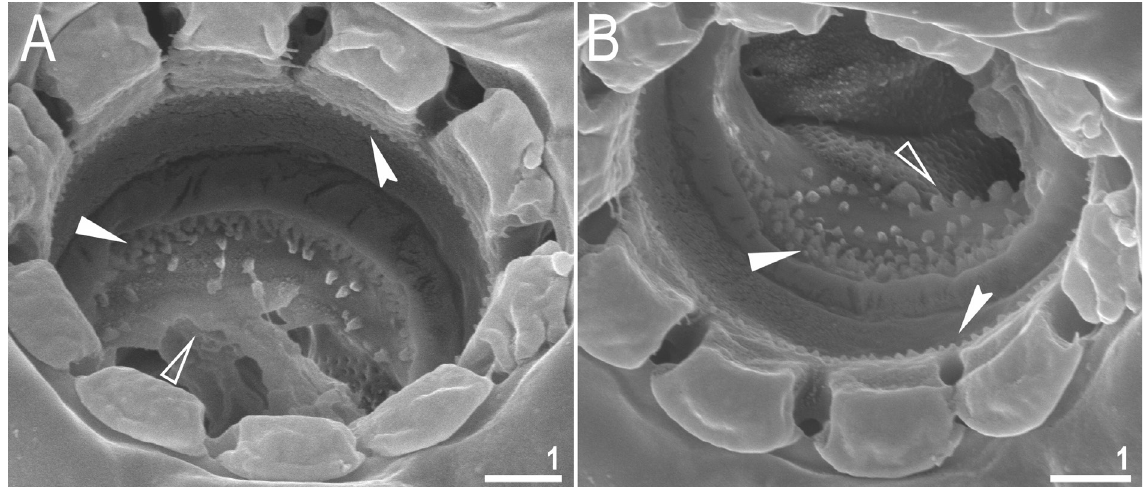
Fig. 16. Tenuibiotus zandrae sp. nov. The oral cavity armature seen in SEM (paratype). The oral cavity armature of a single paratype seen in SEM from different angles, dorsal (A) and ventral (B) view, respectively. Filled indented arrowheads indicate the first band of teeth in the oral cavity, filled flat arrowheads indicate the second band of teeth in the oral cavity, whereas empty flat arrowheads indicate the third band of teeth in the oral cavity. Scale bars in